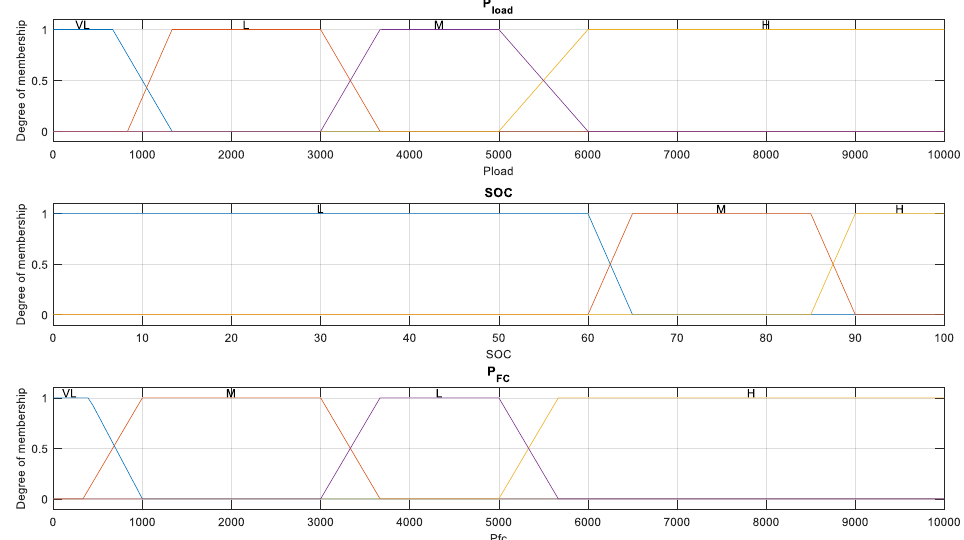
Figure 3. The input-output membership functions of the fuel cell–fuzzy logic control (FC–FLC). Table 1. FC system fuzzy Table 1. FC system fuzzy rules. Table 1. FC system fuzzy rules.